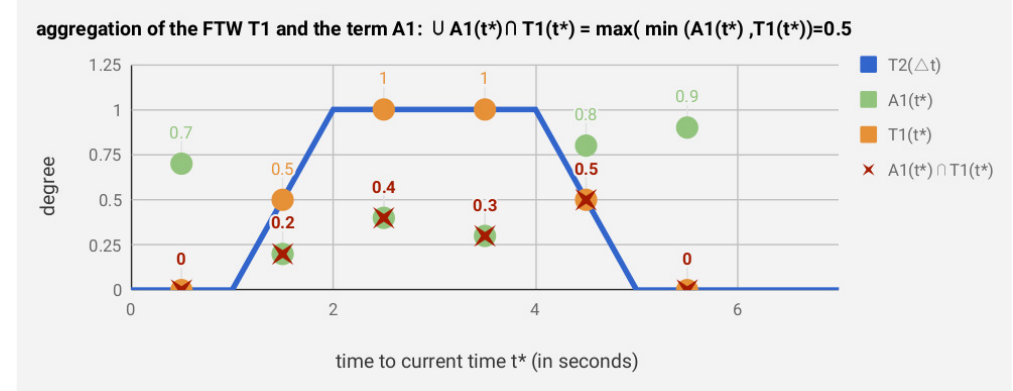
) [1 s, 2 s, 4 s, 5 s] (in magnitude of i